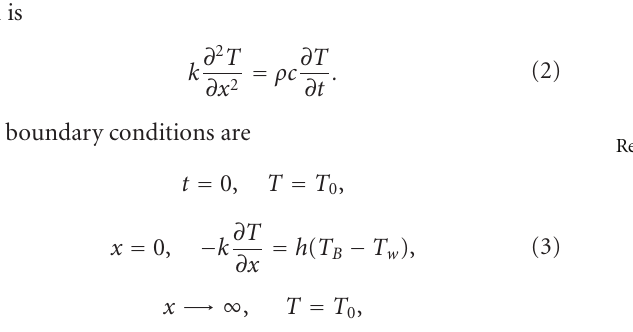
Figure 10: The local Nusselt number distribution on the surface with V-shaped rib turbulators